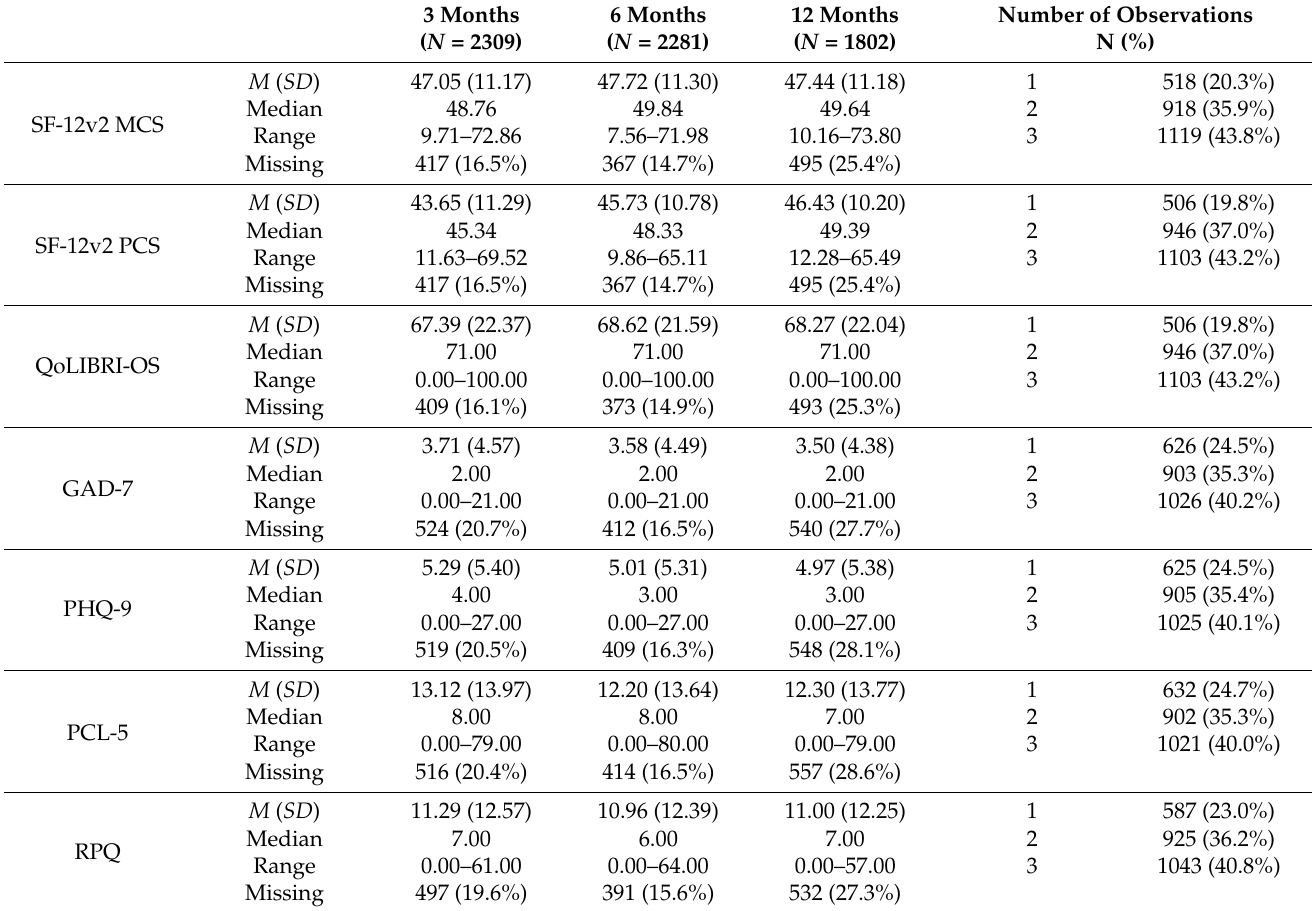
Table 2. Mean values for each outcome at the three time